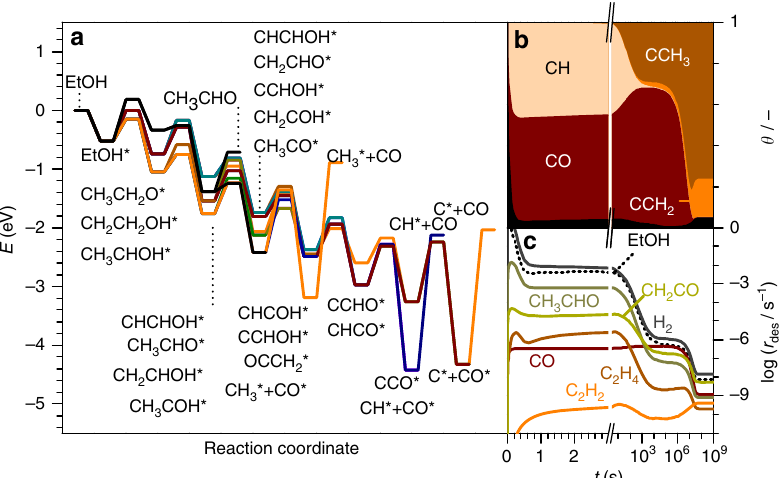
Fig. 4 Ethanol decomposition on Pd(111). a Simpli fi ed DFT-Reaction pro fi le, only considering transition states within 0.30 eV energy windows for each TS. b Surface coverages as a function of time at the reaction conditions: T = 600 K, P ethanol = 1 atm. Main intermediates are labeled, while the black area stands for the small intermediate fractions together with the empty sites. c Desorption rate of ethanol and several products as a function of time